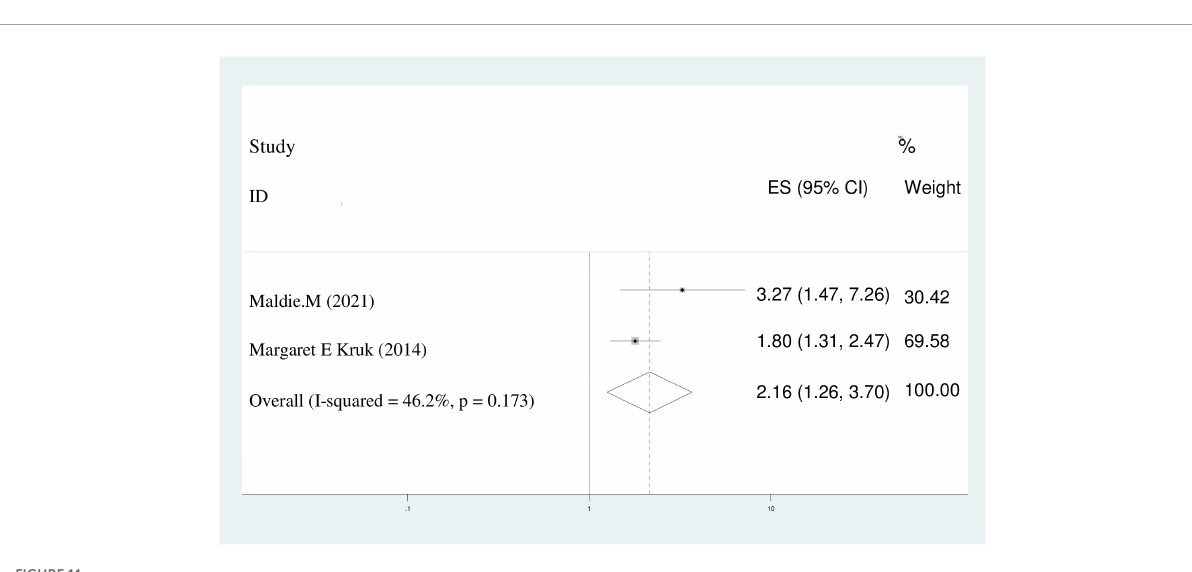
(65), Pakistan 97.4% (66), Pakistan 99.7% (67), and Peru 97.4%